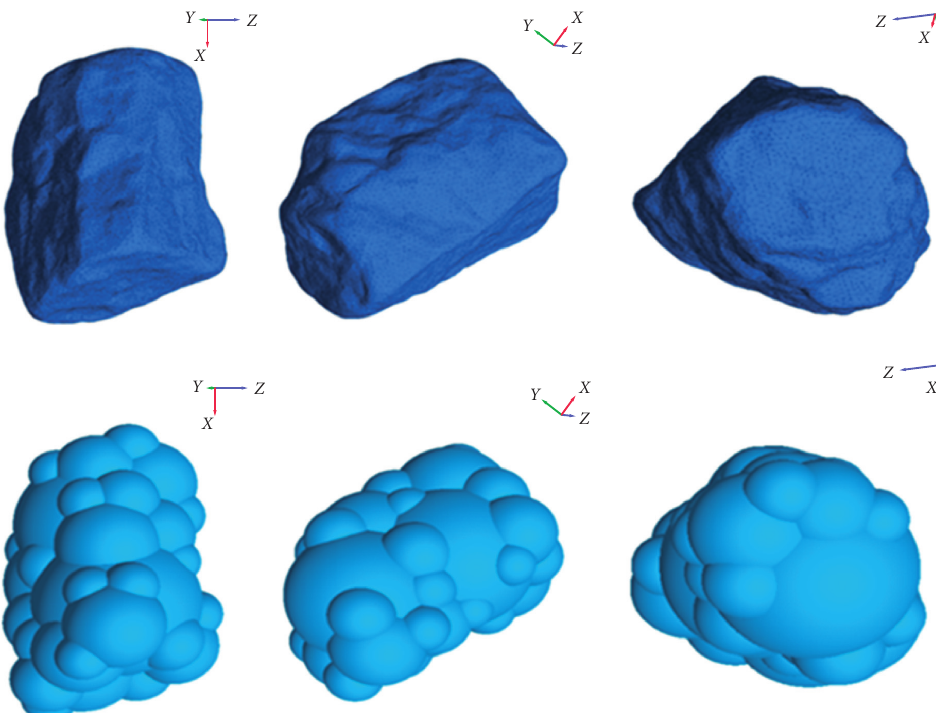
Figure 5: Realistic ballast model using 3D scanning technology and PDC 3D .